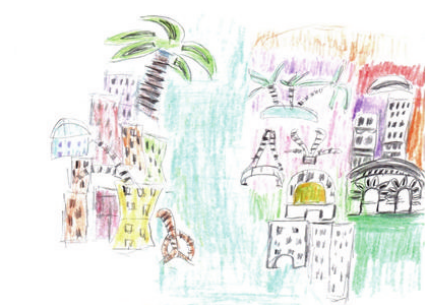
Figure 5: Drawings of the visual phenomena made by the patient (case